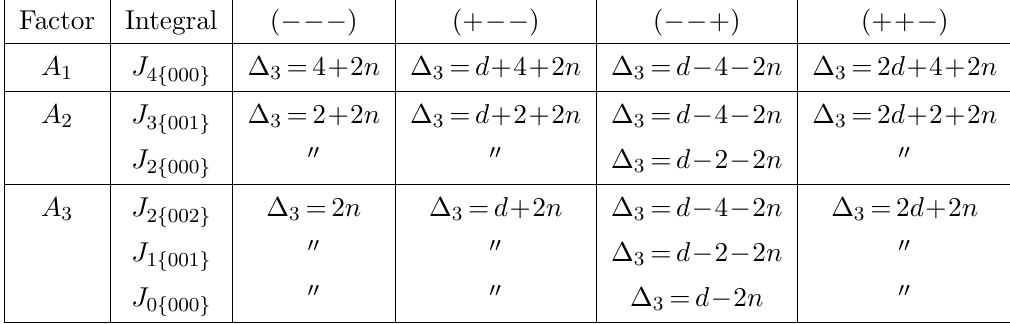
T (cid:22) O I i . 1 (cid:23) 1 2 (cid:23) 2